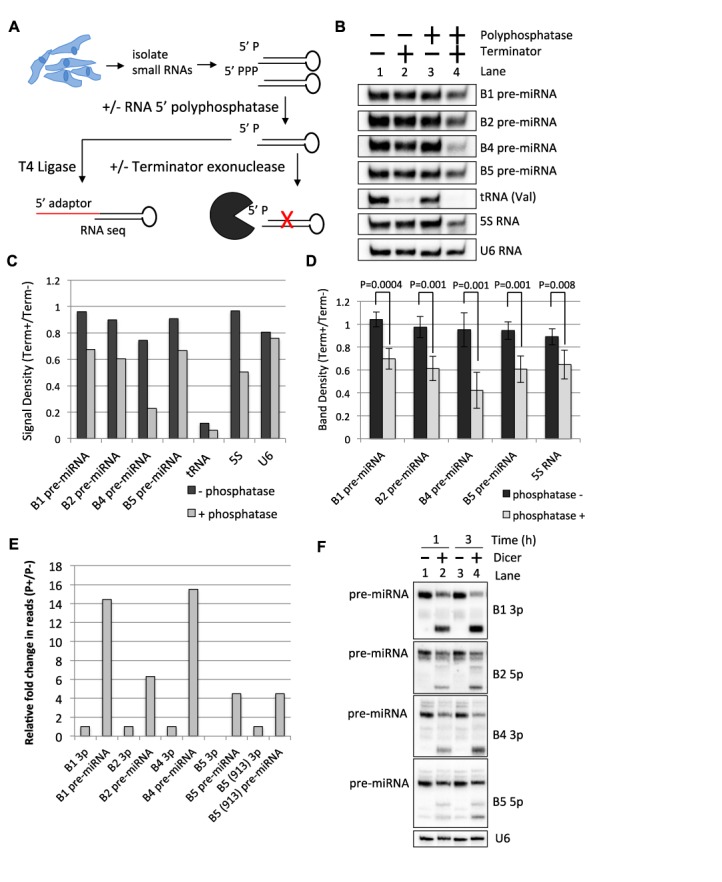
BLV pre-miRNAs are RNAP III primary transcripts. (A) Schematic diagram of the 5′-end characterization of BLV pre-miRNAs. (B) Northern blot analysis on small RNAs purified from HEK293T cells transfected with the individual BLV miRNAs, treated with or without RNA 5′ polyphosphatase, and subsequently treated with or without TerminatorTM, a 5′-monophosphate-dependent exonuclease. (C) Graphical representation of the band densities ratios (TerminatorTM+/TerminatorTM−) from (B) with or without RNA 5′ polyphosphatase treatment. (D) Graphical representation of the band density ratio (TerminatorTM+/TerminatorTM−) of the BLV pre-miRNAs and the 5S RNA with or without RNA 5′ polyphosphatase treatment as determined by northern blot analysis from four independent biological replicates. The bars represent the average ratio +/− the standard deviation (n = 4). (E) Fold change relative to the respective 3p miRNAs in the number of small RNA-seq reads of RNAs consistent with pre-cursors to the BLV miRNAs with or without RNA 5′ polyphosphatase. (F) Northern blot analysis of BLV pre-miRNAs isolated from HEK293T cells transfected with BLV miRNA expression vectors and treated with or without Dicer in vitro.